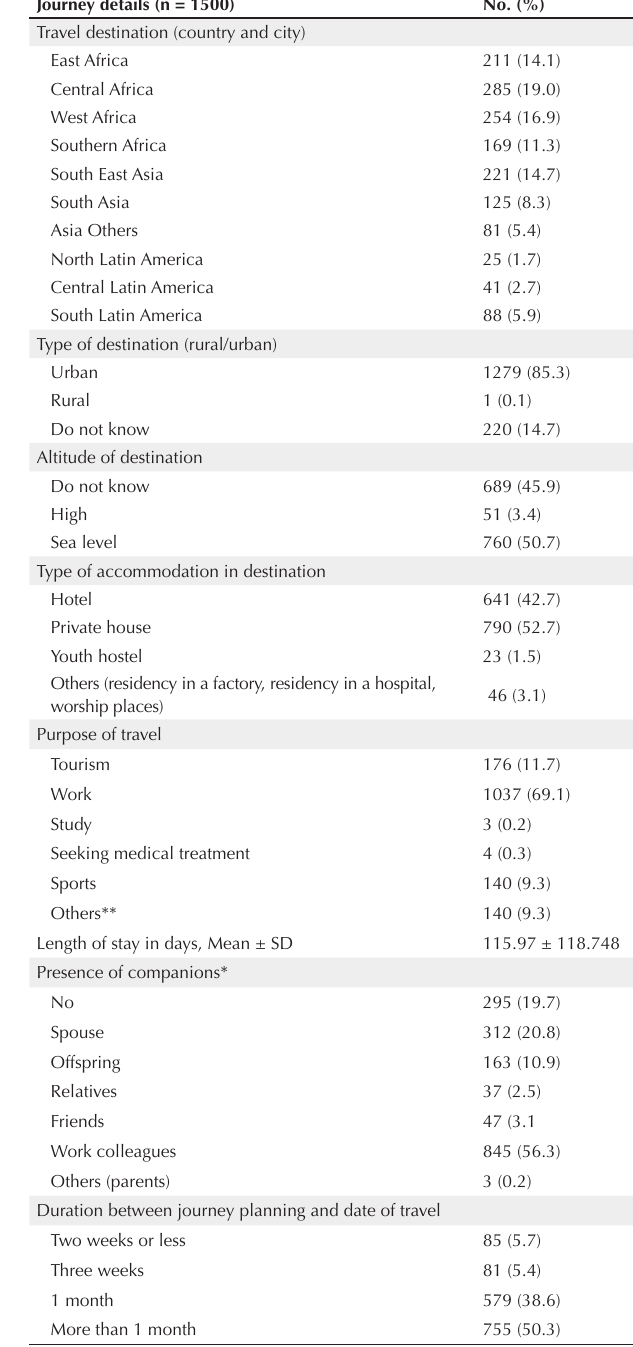
Table 1. Distribution of the Travelers at Cairo International Airport According to Their Socio-Demographic Characteristics Socio-Demographics Characteristics (n = 1500)